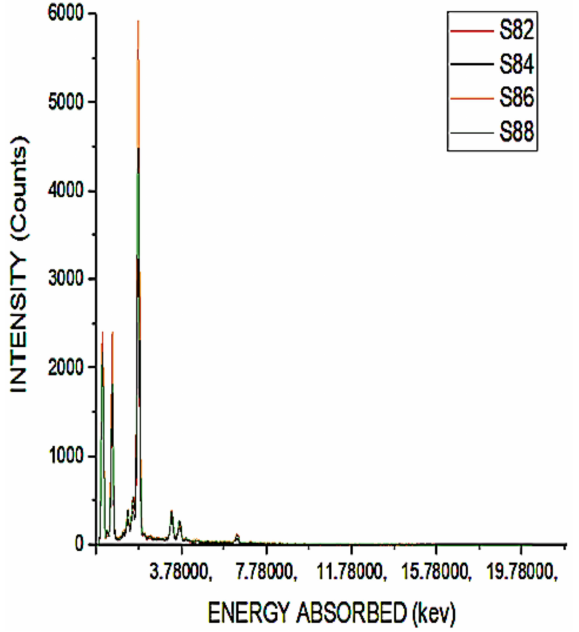
Figure 5. Chemical composition of S82 to S88.